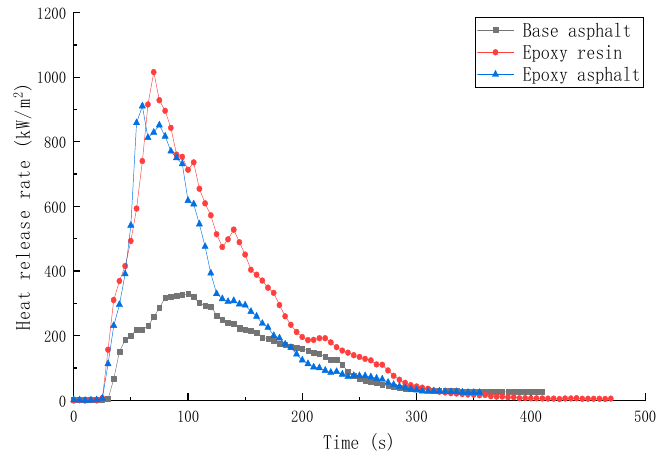
Figure 7. HRR of different materials.